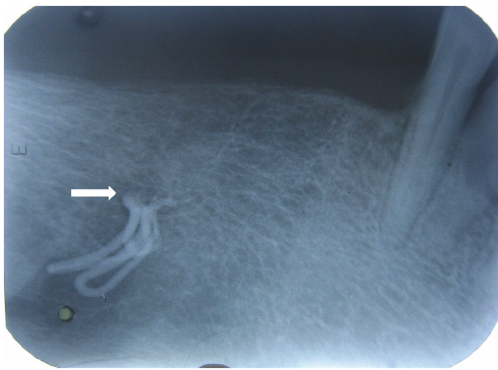
Figure 1: Intraoral photograph showing the previous surgical site which was firm and tender on palpation.